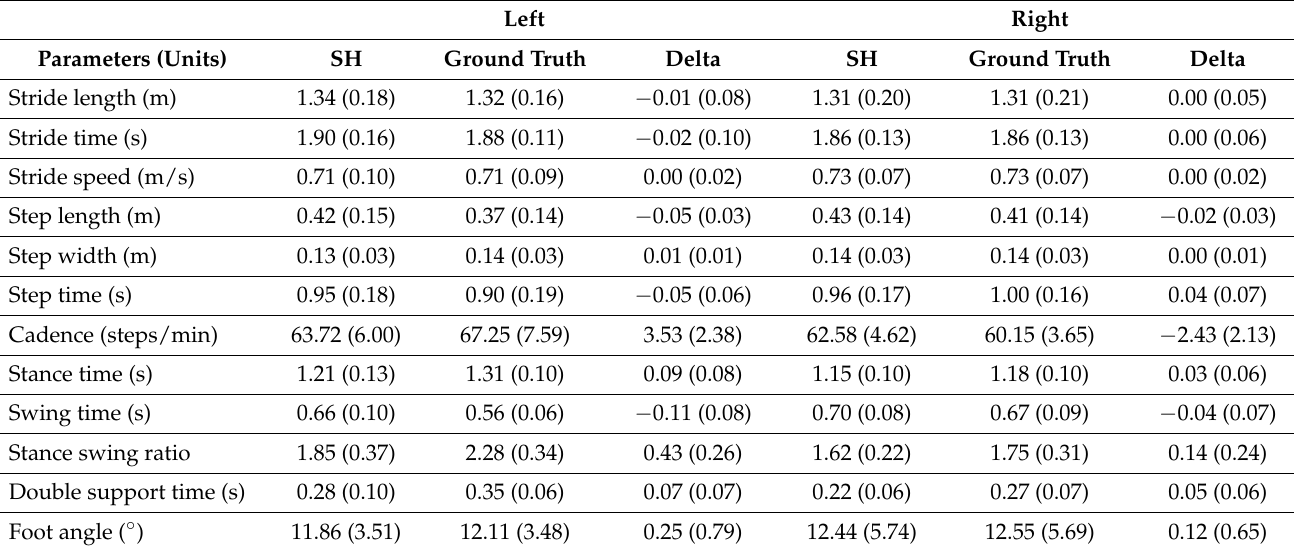
Table 10. Stride parameters for participant one from the Smart Hallway (SH) compared to ground-truth foot-event stride parameters for the Cane test (mean and standard deviation in brackets).